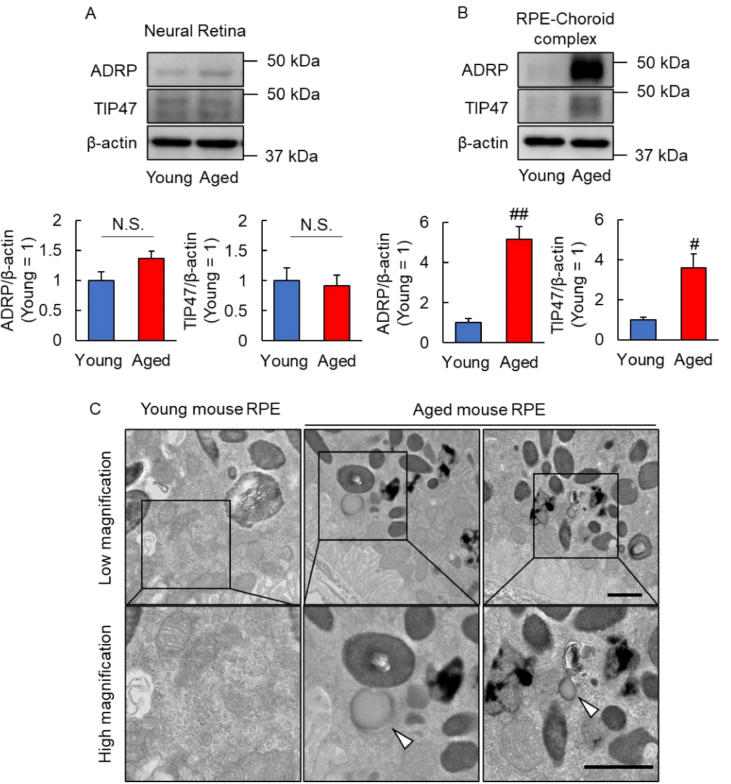
Figure 1. Changes in lipid droplet in the eye with age. ( A , B ) Expression levels of lipid droplet membrane proteins for young and aged mice in neural retina ( A ) and RPE-choroid complex ( B ). Data are the means ± standard error of means (SEMs) ( n = 4 or 5 mice/group). ## p < 0.01, # p < 0.05 vs. young (Student’s t -test or Welch’s t -test). N.S.—No significant difference. ( C ) The representative transmission electron microscope (TEM) image of the RPE cell ( n = 3 mice/group). Arrow head shows lipid droplet. Scale bar shows 1 µ m.